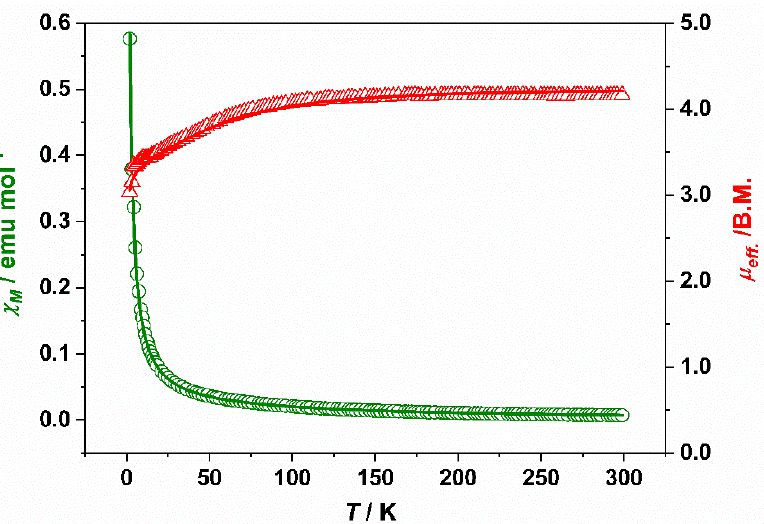
Figure 4. Temperature dependence of the molar susceptibility (o) and magnetic moment ( ∆ ) for compound [Ru 2 Cl( µ -O 2 CC 6 H 4 - o -OMe) 4 (EtOH)] ( 1b ). Solid lines are the product of a least-squares fit of the experimental data to the model indicated in the text.